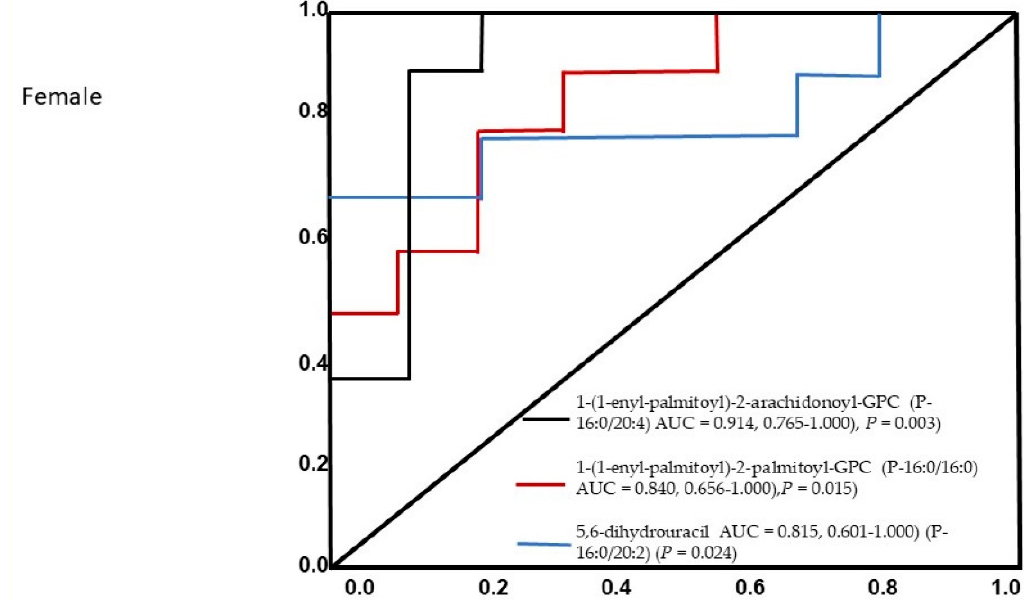
Figure 3. The ROC analysis results from the four diagnostic models calculated from the logistic regression analysis for female patients. The performance of each biomarker model was evaluated by the area under the ROC curve (AUC) and the determination of sensitivity and specificity at the optimal cut-off point defined by the minimum distance to the top-left corner.